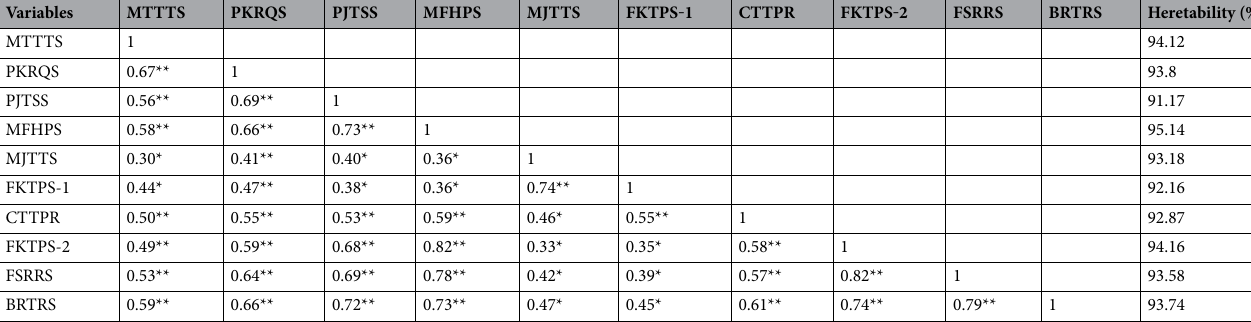
Table 1. Correlation analysis among the phenotypic data of 185 wheat genotypes evaluated for their reaction to 10 Pucnina triticina races.